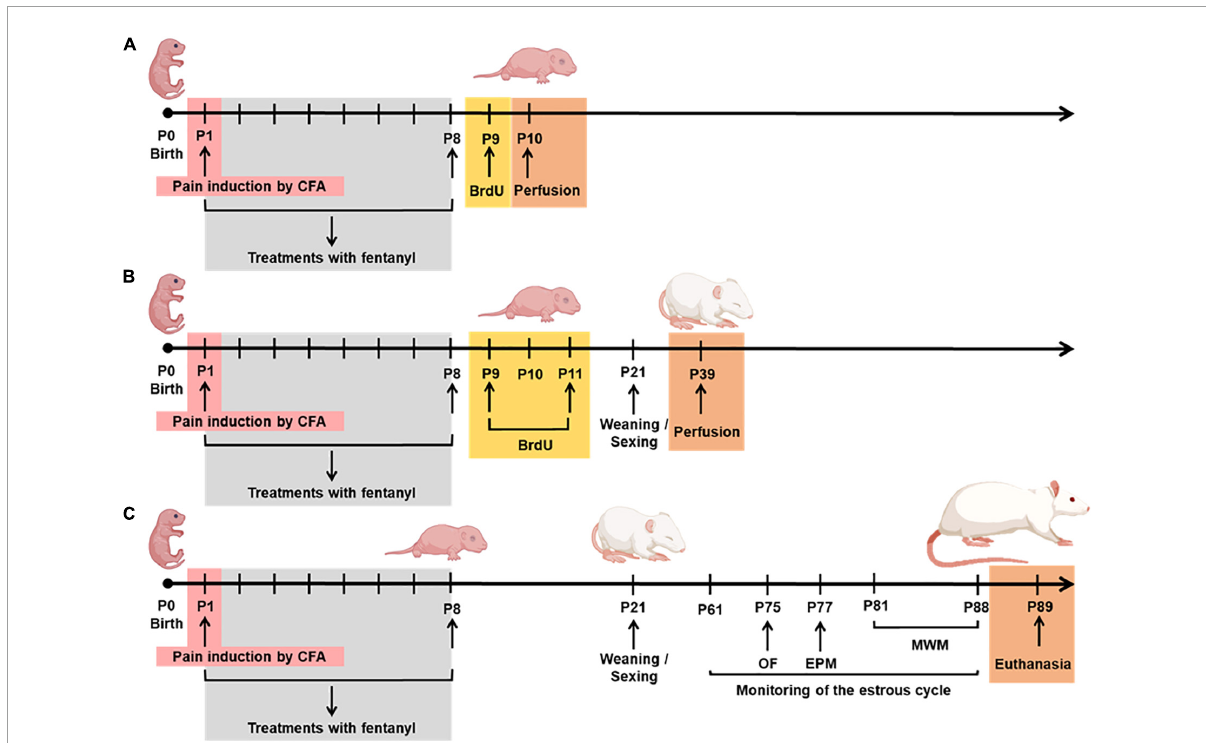
FIGURE2 Experimental protocol from P1-P89. (A) Cell proliferation on P10; (B) neurogenesis on P39; (C) behavior and learning in adulthood. P, postnatal; CFA, inflammatory agent complete Freund’s adjuvant; BrdU, 5-bromo-2-deoxyuridine; OF, open field; EPM, elevated plus maze; MWM, Morris water